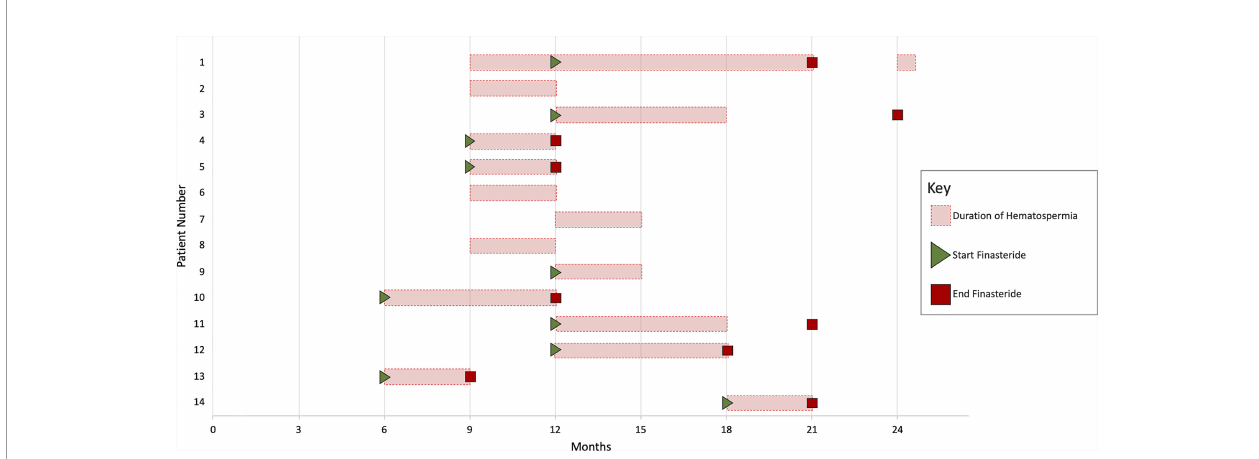
FIGURE 3 | Swimmer ’ s plot of 14 patients who experienced hematospermia. Error bars represent the beginning and end of hematospermia in months post-SBRT. Green triangles and red boxes symbolize the start and stop of 5-alpha reductase inhibitor treatment